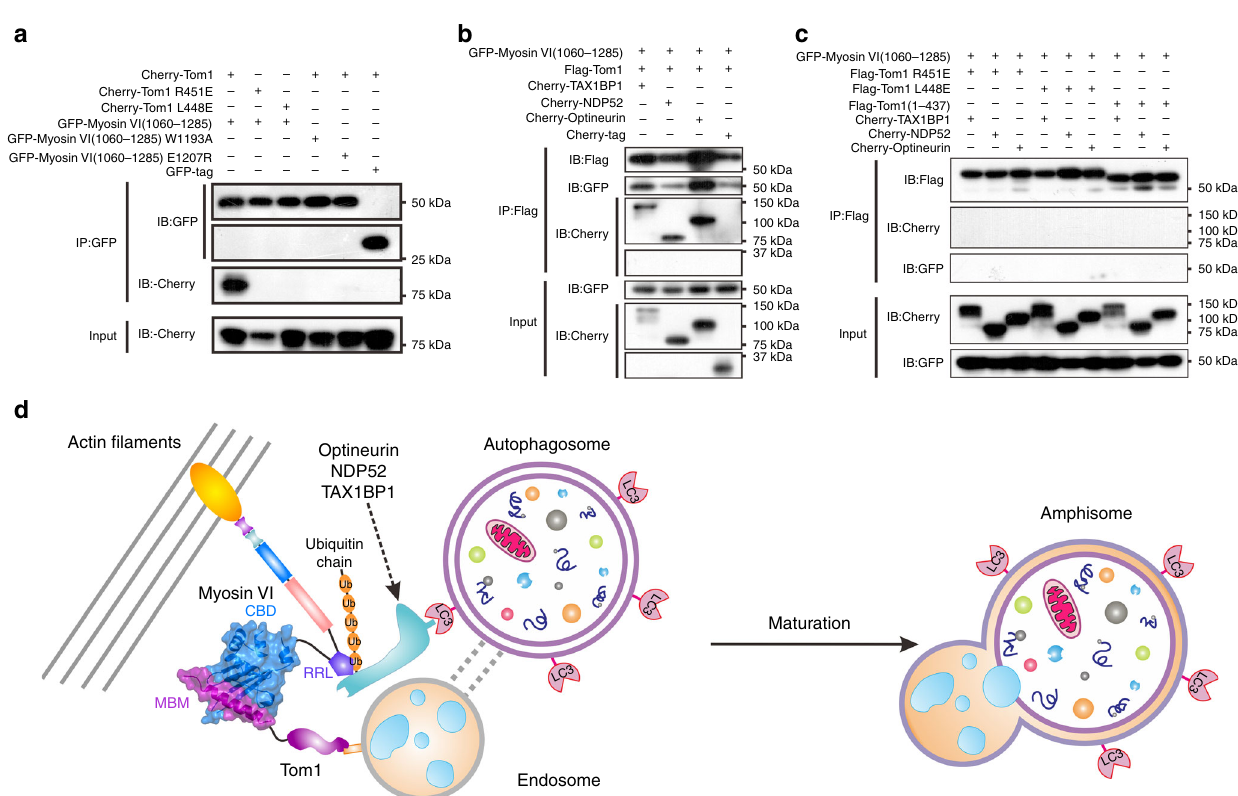
Fig. 5 Myosin VI can link Tom1 with autophagy receptors. a A co-immunoprecipitation assay showing that point mutations of key interface residues observed in the Myosin VI/Tom1 complex structure abolish the speci fi c interaction between Myosin VI(1060 – 1285) and Tom1 in cells. In this assay, cell extracts were prepared from HEK293T cells co-transfected with different combinations of plasmids as indicated, and 5% of each extracts were used as loading controls (bottom panel). b A co-immunoprecipitation assay revealing that Myosin VI(1060 – 1285), Tom1 and autophagy receptor TAX1BP1, NDP52, or Optineurin, can form ternary complexes in co-transfected cells. c A co-immunoprecipitation assay showing that mutations of Tom1, which can disrupt the interaction between Myosin VI(1060 – 1285) and Tom1, can also abolish the formation of the Tom1/Myosin VI/autophagy receptor ternary complex in cells. In this assay, cell extracts were prepared from HEK293T cells co-transfected with different combinations of plasmids as indicated, and 5% of each extracts were used as loading controls (bottom panel). Source data are provided as a Source Data fi le. d A proposed model depicting the tethering of endosome and autophagosome mediated by Myosin VI in cooperate with Tom1, the autophagy receptors, NDP52, TAX1BP1, and Optineurin as well